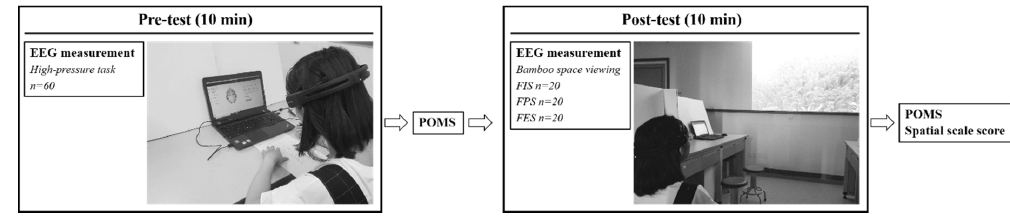
Figure 5. Study procedure (FIS = forest interior space, FPS = forest path space, FES = forest external space).